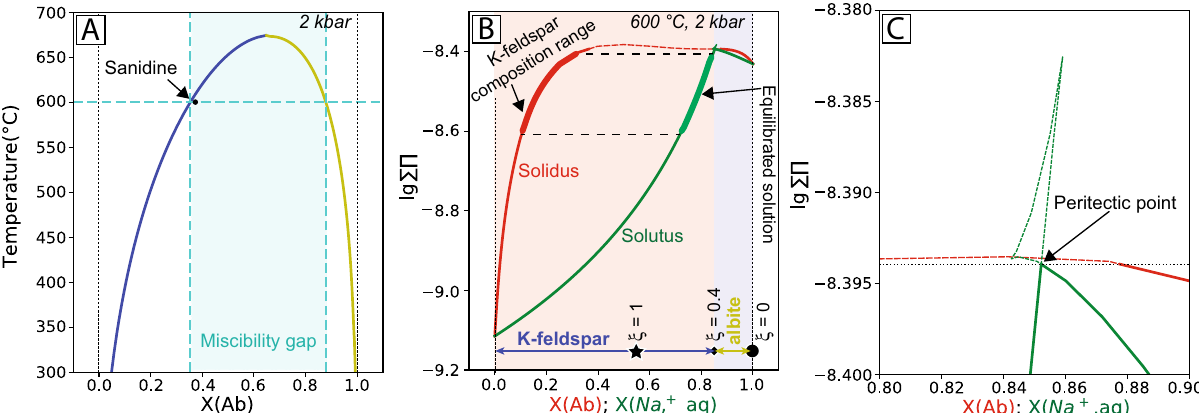
Fig. 3 Thermodynamic modelling of the stability of Na-K-feldspars and the evolution of solids and solution composition during hydrothermal reaction. Starting compositions of fl uids and minerals are listed in Supplementary Table 2. Calculated solvus (co-existence of Na-rich and K-rich alkali feldspar) in the alkali feldspar-aqueous system ( A ) and Lippmann diagram for the aqueous – alkali feldspar – plagioclase system ( B ), as well as its upper-right fragment ( C ) calculated at P = 2 kbar, T = 600°C. The solid and dashed lines in the Lippmann diagram are the stable and metastable segments, respectively, of the solidus and solutus curves. The peritectic point is where the aqueous phase co-exists with the two solid solution phases. X (Ab) is the percentage of albite end-member in each phase, and X (Na + ,aq) the composition of the co-existing aqueous fl uid ( X (Na + ,aq) = a (Na + )/[ a (Na + ) + a (K + )], where a is activity). In B the symbol ξ represents reaction progress. ξ is the fraction of sanidine replaced by albite, assuming negligible dissolution of sanidine. This value highlights the solution compositions at different stages of sanidine replacement by albite, based on mass balance calculations in our experiments. This indicates that the bulk solution is expected to become saturated with respect to K-feldspar at ξ